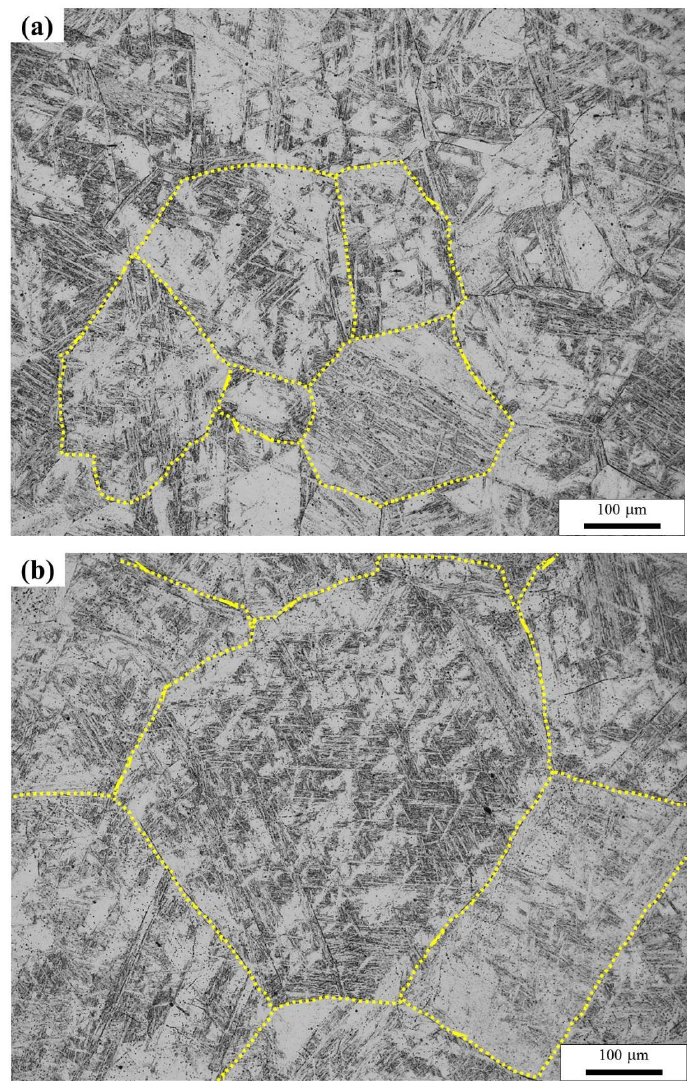
Figure 8. Prior austenite grains following a peak temperature of 1300 °C quenching by water for the air-cooled initial microstructure ( a ), for the water-quenched initial microstructure ( b ). The dilation of each specimen Δ L was obtained as a function of temperature and time on continuous heating as shown in Figure 9. Based on the data, the dilatometry curve Δ L/L 0 and the first derivative with respect to temperature d ( Δ L/L 0 )/dT were plot- ted for both specimens during heating. The starting temperature of austenite transfor- mation (A c1 ) for the air-cooled initial microstructure (688 °C) (Figure 9a) is higher than that of the water-quenched initial microstructure (653 °C) (Figure 9b). Corresponding phase fraction evolution and the rate of phase transformation of ferrite to austenite, ob- tained by taking numerical derivative of fraction of austenite formed at each time step (since the fraction of austenite is a dimensionless number, the formation rate of austenite is expressed as (s − 1 )), are shown in Figure 9c and Figure 9d, respectively. The phase frac- tion of austenite was estimated from dilatometry using lever rule by linear extrapolation of ferrite phase field dilation and austenite phase field dilation beyond the A c1 and A c3 temperature, respectively, and applying lever rule in the A c1 A c3 range to calculate the austenite phase fraction using the equation below: f γ,T = δl e,α −δl m δl e,α −δl e,γ where δ l e, α , δ l e, γ , δ l m are the extrapolated dilation from the ferrite phase field, extrapolated dilation from the austenite phase field, and the experimental dilation for given temper- ature. On heating, austenite transformation happens in the air-cooled initial microstruc- ture at a higher Ac 1 temperature, leading to smaller prior austenite grain size compared with water-quenched initial microstructure for the same peak heating temperature. It should also be noted that the rate of formation of austenite from a martensitic starting microstructure is faster than the rate of formation of austenite from a polygonal ferritic starting microstructure. To understand the reason for such an effect of initial microstructure on Ac 1 and Ac 3 , the driving force for austenite transformation on heating was calculated using Ther- moCalc. Since the water-quenched initial microstructure was subjected from water